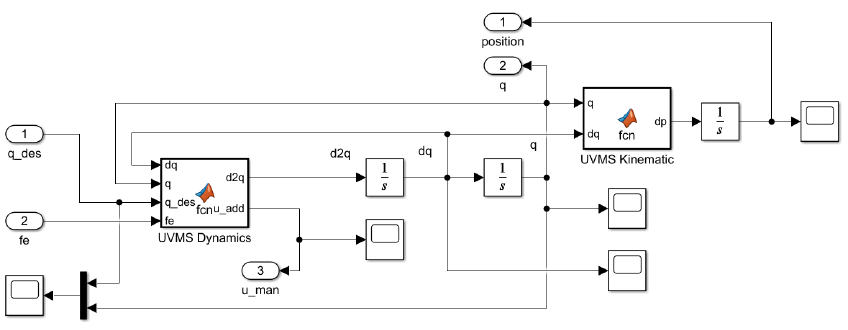
Figure 8. Simulink submodel of UVMS.